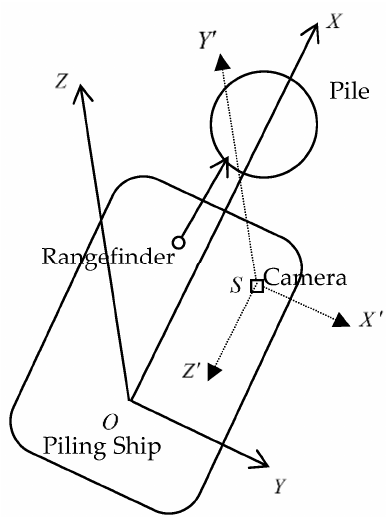
Figure 6. Ship Fixed Photogrammetry coordinate system and Ship Fixed coordinate system.